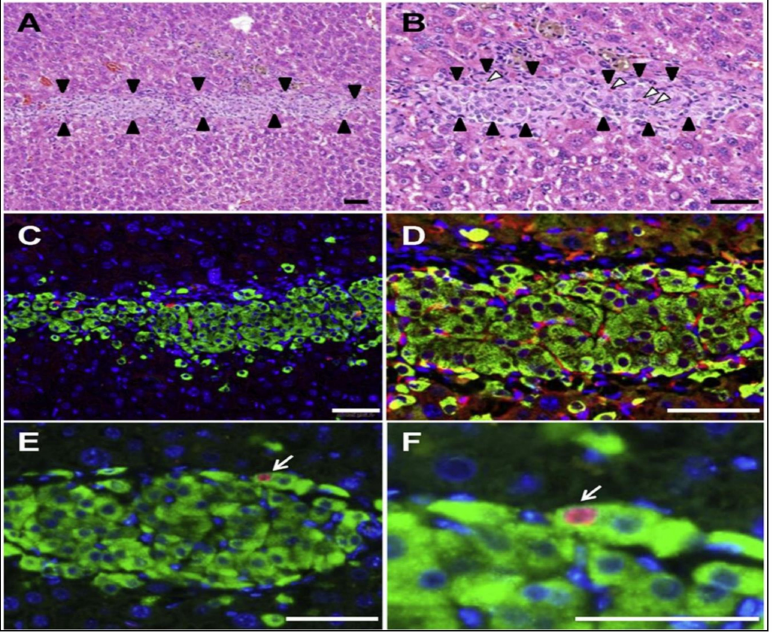
Figure 5. Histological analysis of the islet cell sheets that were engrafted on the surface of the left lat- eral lobe of the liver and covered by the median lobe of the liver. ( A , B ) HE staining of neo-islet tissues between liver lobes on day 28. Neo-islet tissue (black arrowheads) and vascular networks containing blood cells (white arrowheads) are shown. ( C ) Double immune histochemical staining for insulin (green) and glucagon (red) of neo-islet tissues in liver on day 28. ( D ) Double immunohistochemical staining for insulin (green) and CD31 (red) on day 28. ( E , F ) Double immunohistochemical staining for insulin (green) and Ki-67 (red) on day 28. Arrows denote Ki-67/insulin double-positive β -cells in the neo-islet tissue. Bar: 50 mm. Adapted with permission [132]; published by The Japanese Society for Regenerative Medicine,